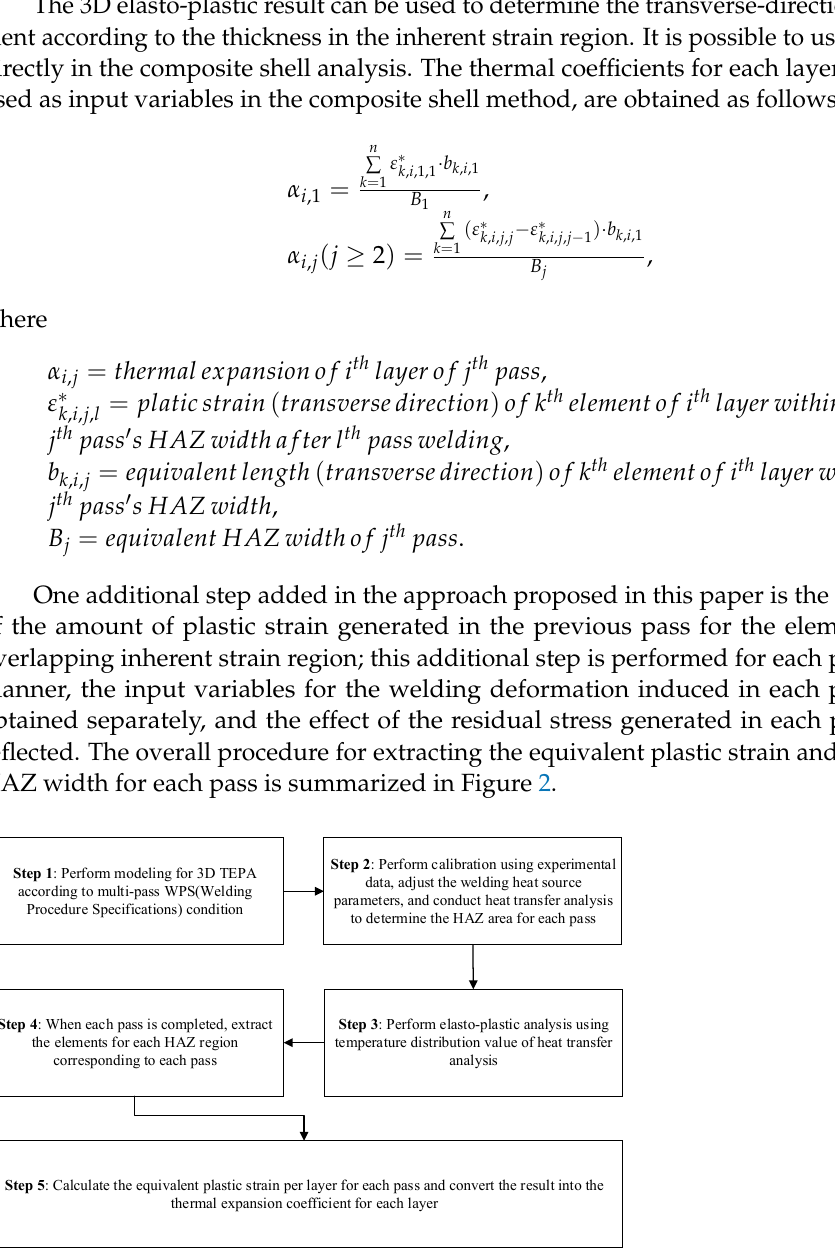
Figure 2. General procedure for extracting input variables in proposed method .